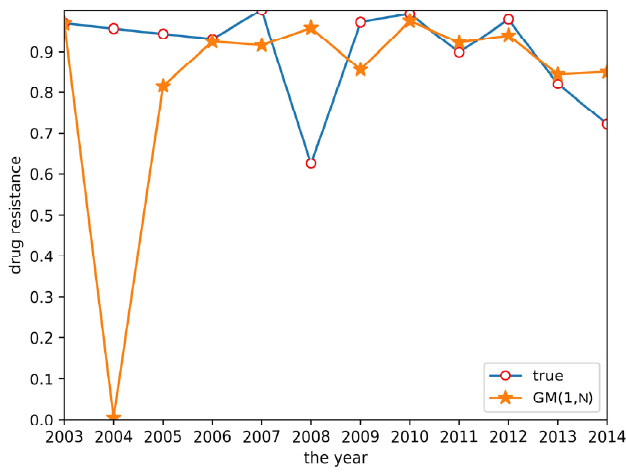
Figure 4. GM(1,N) prediction result.